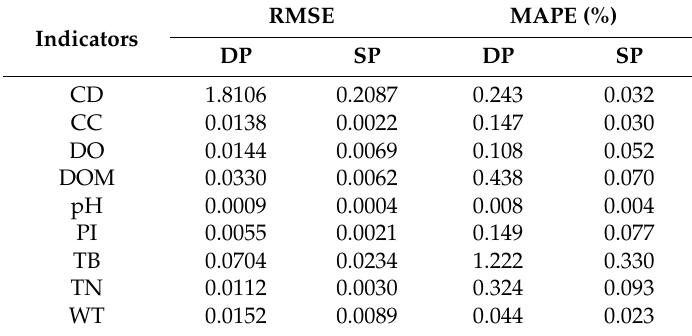
Table 5. The RMSE and Mean Absolute Percentage Errors (MAPE) of default predictors (DP) and the selected predictors (SP) using CS-BP model.